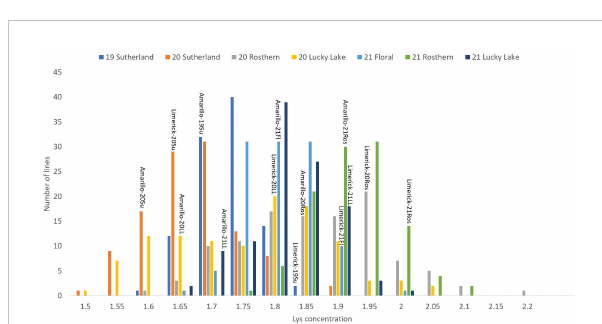
FIGURE 5 Frequency distribution of lysine concentration of PR-25 across seven station-years based on the average of biological replicates for each line in each station-year (two biological replicates in 2019 Sutherland and three biological replicates for the rest of the station- years), and the averaged lysine concentration for the parents of PR- 25 in each station-year.